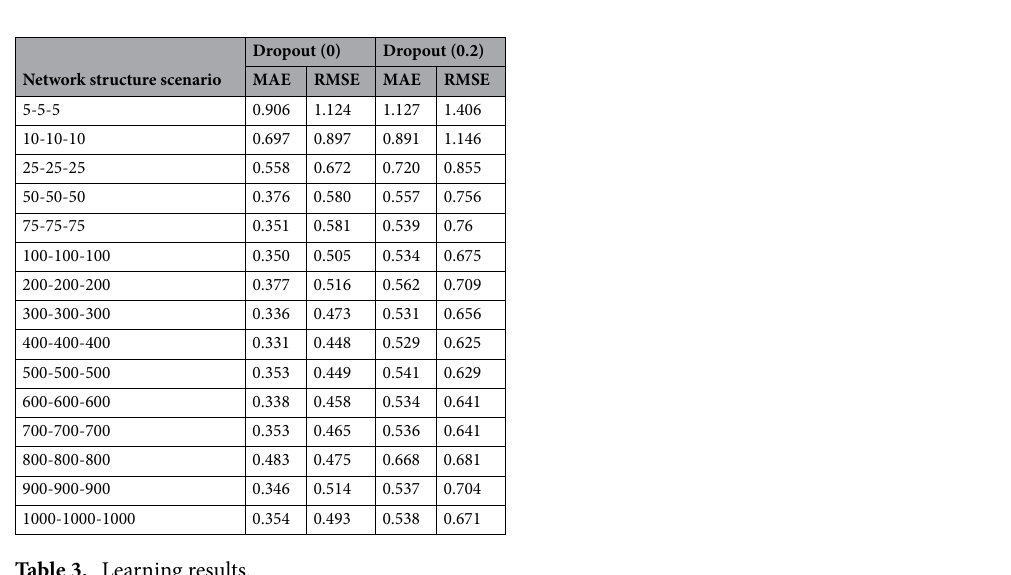
Table 3. Learning